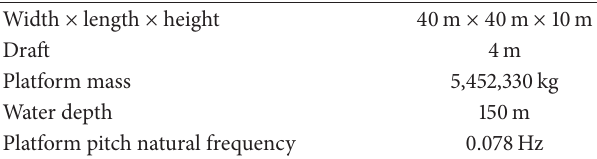
Table 2: Physical properties of the barge